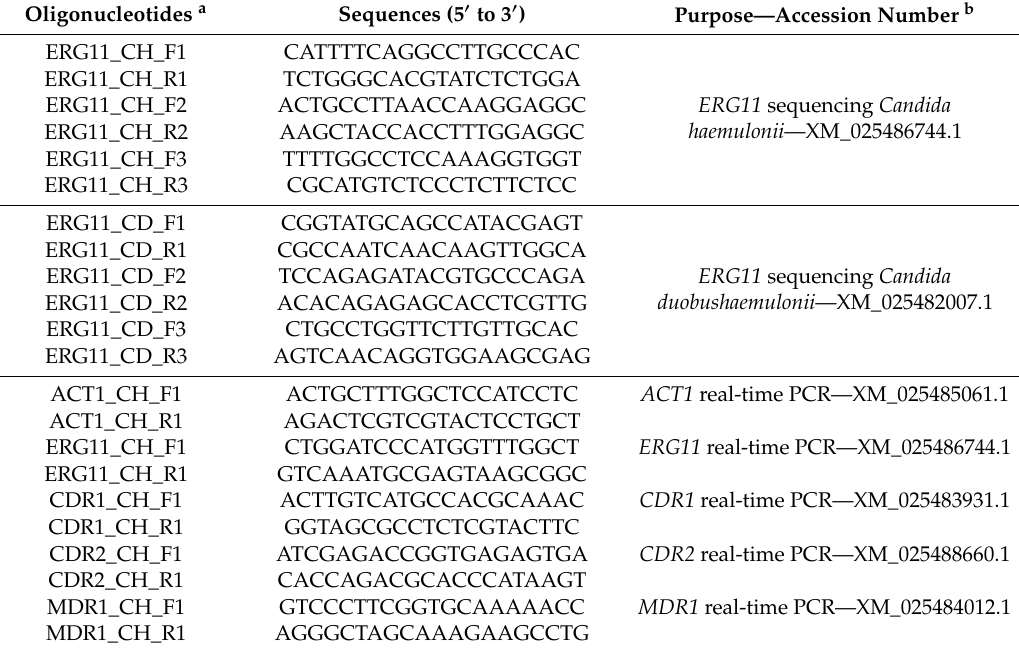
Table 1. Oligonucleotide sequences used in this